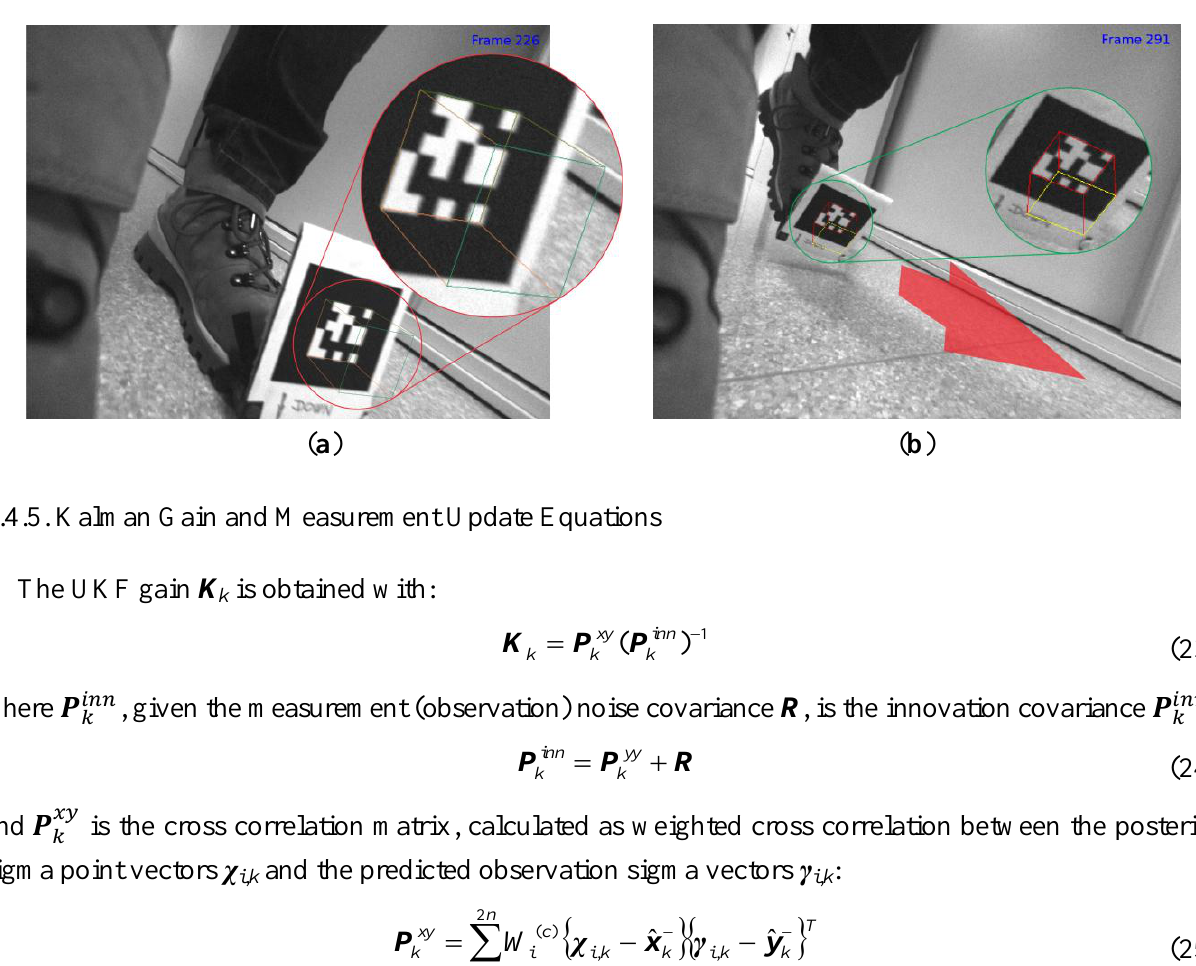
Figure 5. Typical rejected ARTooKitPlus measurements. ( a ) 3D cube overlay of a low confidence ARTooKitPlus marker pose estimation—notice the imperfect 3D cube overlay on the right edge of the marker. ( b ) A typical moving marker image during stance phase of the IMUCC-equipped foot with an otherwise perfectly determined marker